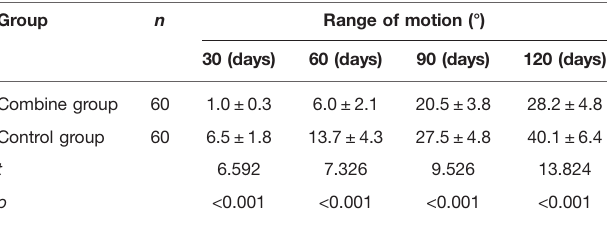
TABLE 2 | Comparison of recovery time for different ranges of joint motion in patients of two groups ( n , (cid:1) x + s). Group n Range of motion (°)